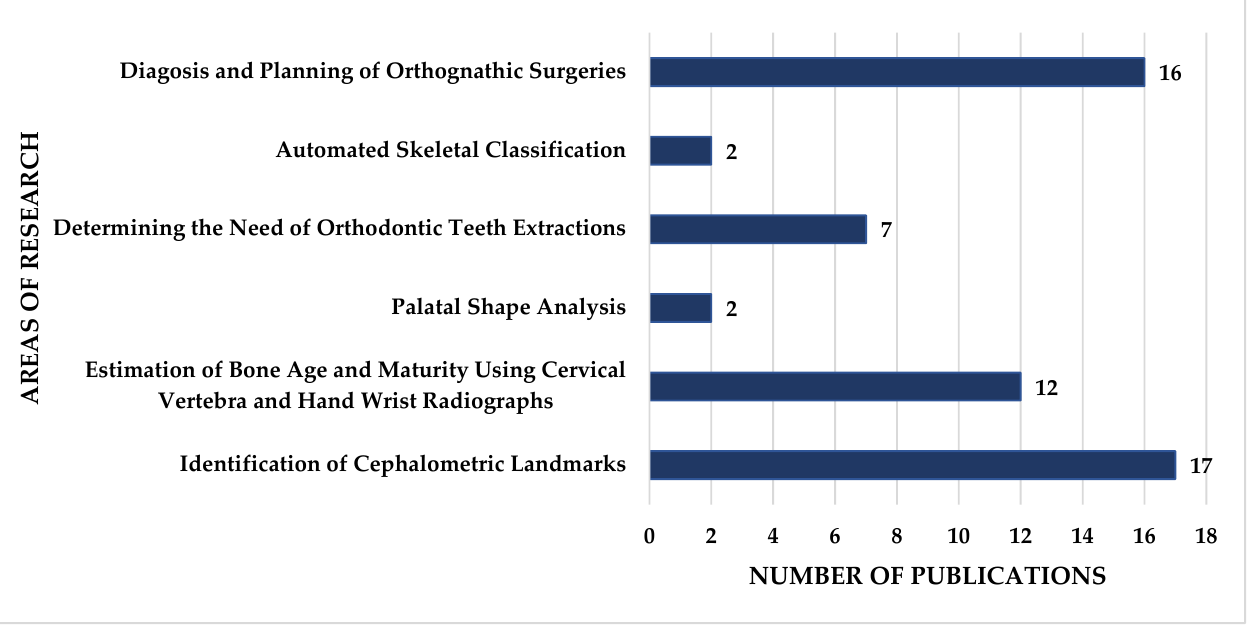
Figure 3. Application of AI in orthodontics.